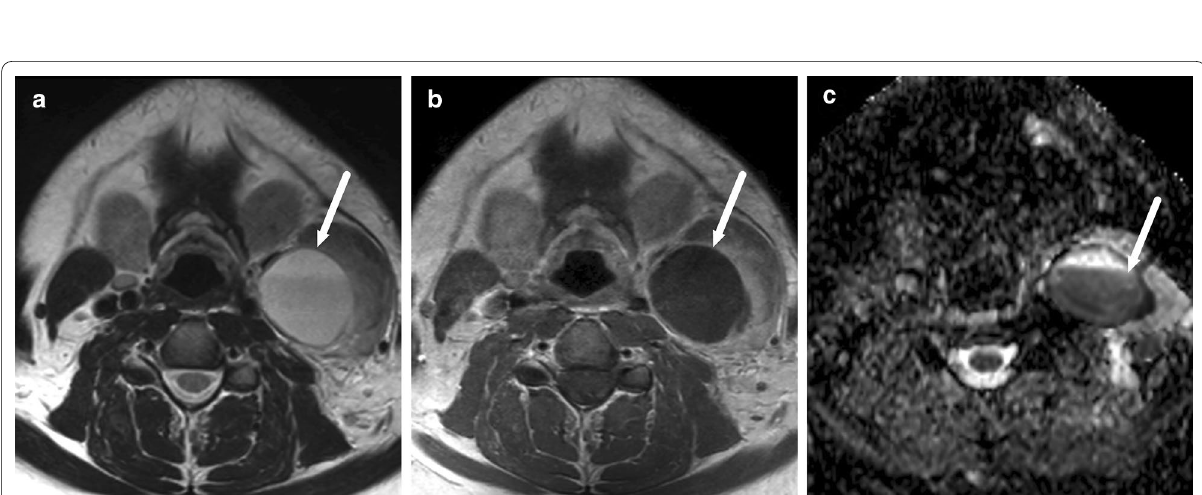
Fig. 31 Infected second branchial cleft cyst (pathology proven). MRI shows a large cystic mass (arrows) under a swollen sternocleidomastoid muscle on axial T2-weighted ( a ) and post-contrast T1-weighted ( b ) images. ADC map shows a layering of purulent fluid ( c ), consistent with a secondary infection of a cystic